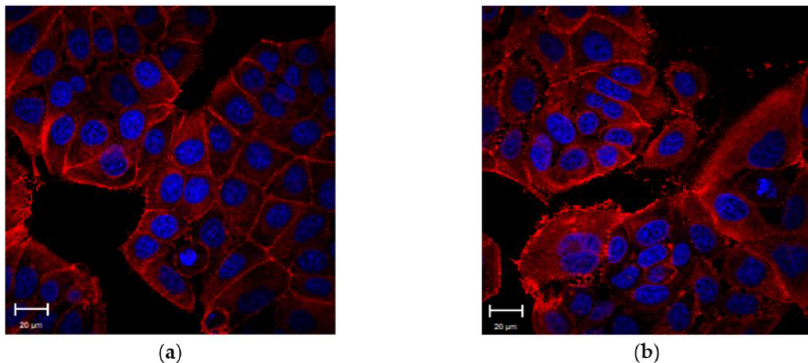
Figure 2. Representative confocal images of control MCF-7 cells (MCF-7 CTR ) ( a ) and treated ones (MCF-7 TGF- β 1 ). MCF-7 TGF- β 1 were treated with TGF- β 1 (5 ng/mL) for 48 h. ( b ). F-actin is labeled in red and nuclei in blue. Acquisitions were performed by Zeiss LSM700 (Zeiss) confocal